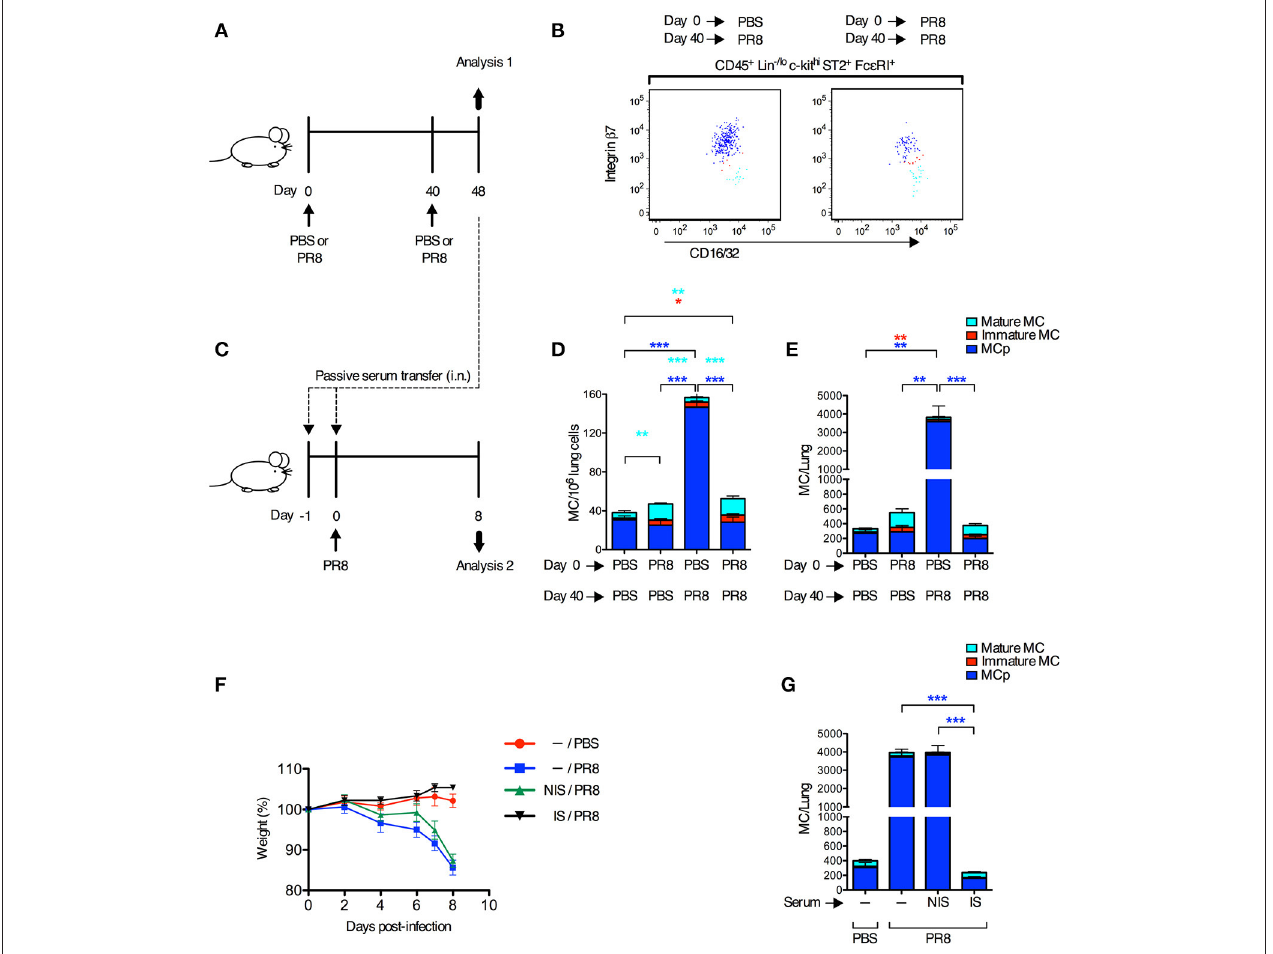
FIGURE 2 | Adaptive immune responses suppress the recruitment of MCp to the lung upon a secondary infection with influenza. (A,B,D,E) Forty days after PR8 influenza infection or PBS installation, mice were infected with PR8 influenza virus or given PBS. (B) Representative dot plots of the three lung subpopulations of CD45 + Lin − / lo c-kit hi ST2 + Fc ε RI + CD16/32 int mast cells (MC), which were distinguished based on cell surface expression level of integrin β 7, as lung MCp (integrin β 7 hi ; dark blue), immature MC (integrin β 7 int ; red), and mature MC (integrin β 7 − / lo ; light blue). (D) The frequency (MC/10 6 lung cells) and total number (E) of MC subpopulations per mouse. The results in (D,E) are pooled from two independent experiments ( n = 5–9). Mean ± SEM, one-way ANOVA with Tukey’s multiple comparisons test. (C,F,G) Naïve mice received pooled serum from influenza-infected (immune serum; IS) or PBS-injected mice (non-immune serum; NIS) i.n. on days − 1 and 0 before PR8 infection. Controls were given only PBS or PR8 on day 0. (F) The weight per mouse relative to the weight at day 0 (weight %). (G) The total number of MCp per mouse lung. The results in (F,G) are pooled data from two independent experiments ( n = 6–9). Mean ± SEM, one-way ANOVA with